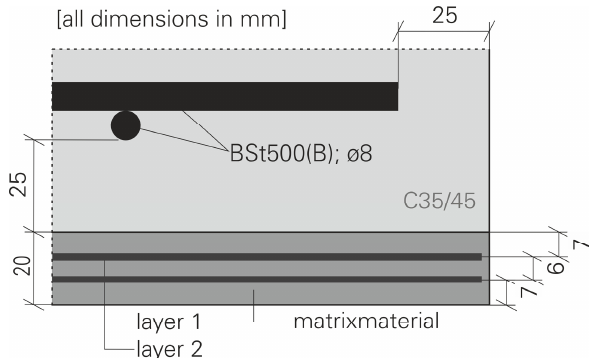
Figure 2. Basic structure of the strengthening layer; Hering [17].